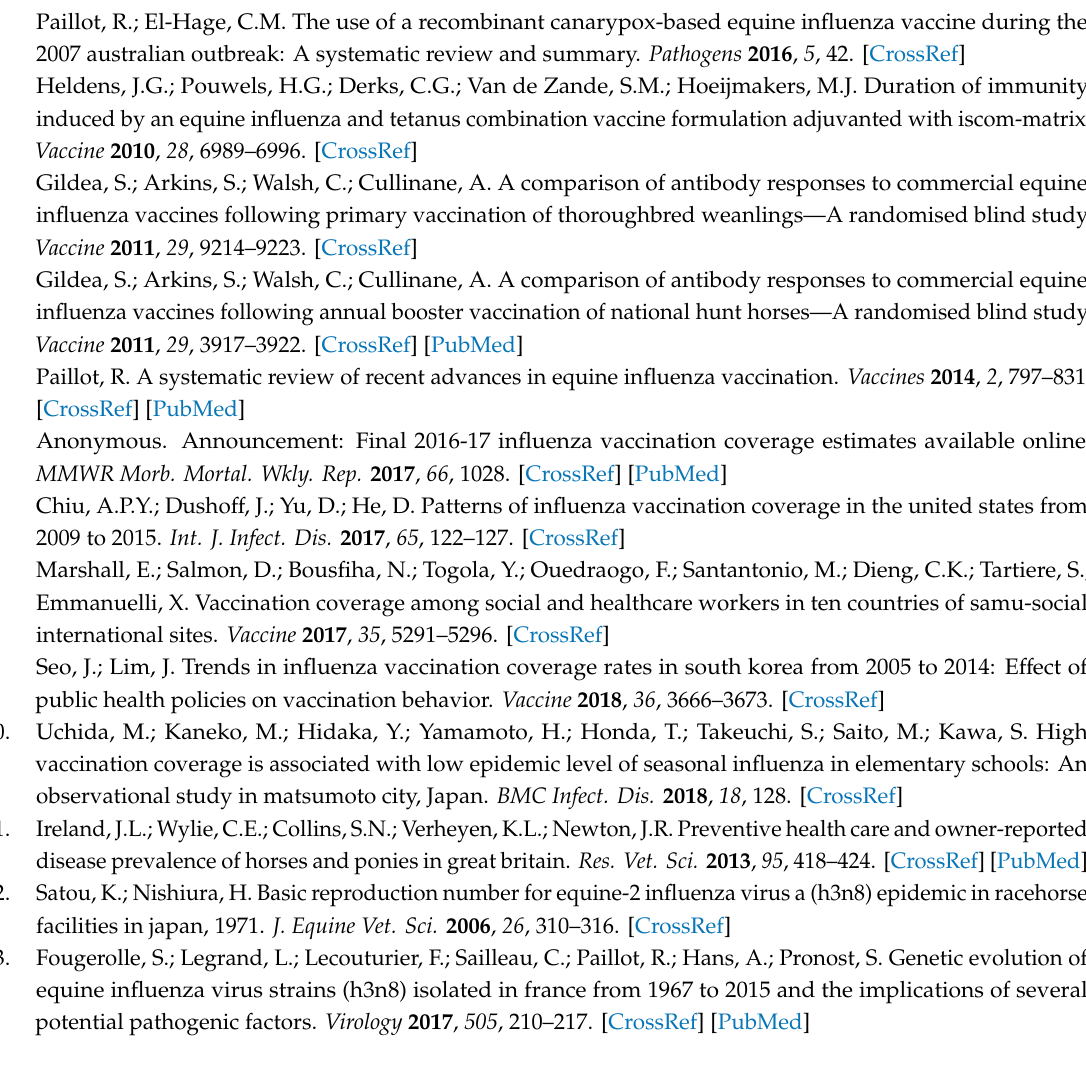
Table S1: Details of serum samples analyzed and SRH antibody titers, by category, by regional origin. Table S2: HA amino acid alignment. Figure S1: Number of breeding centers per French region in 2017, all equids considered (race and sport horses, ponies, heavy horses and